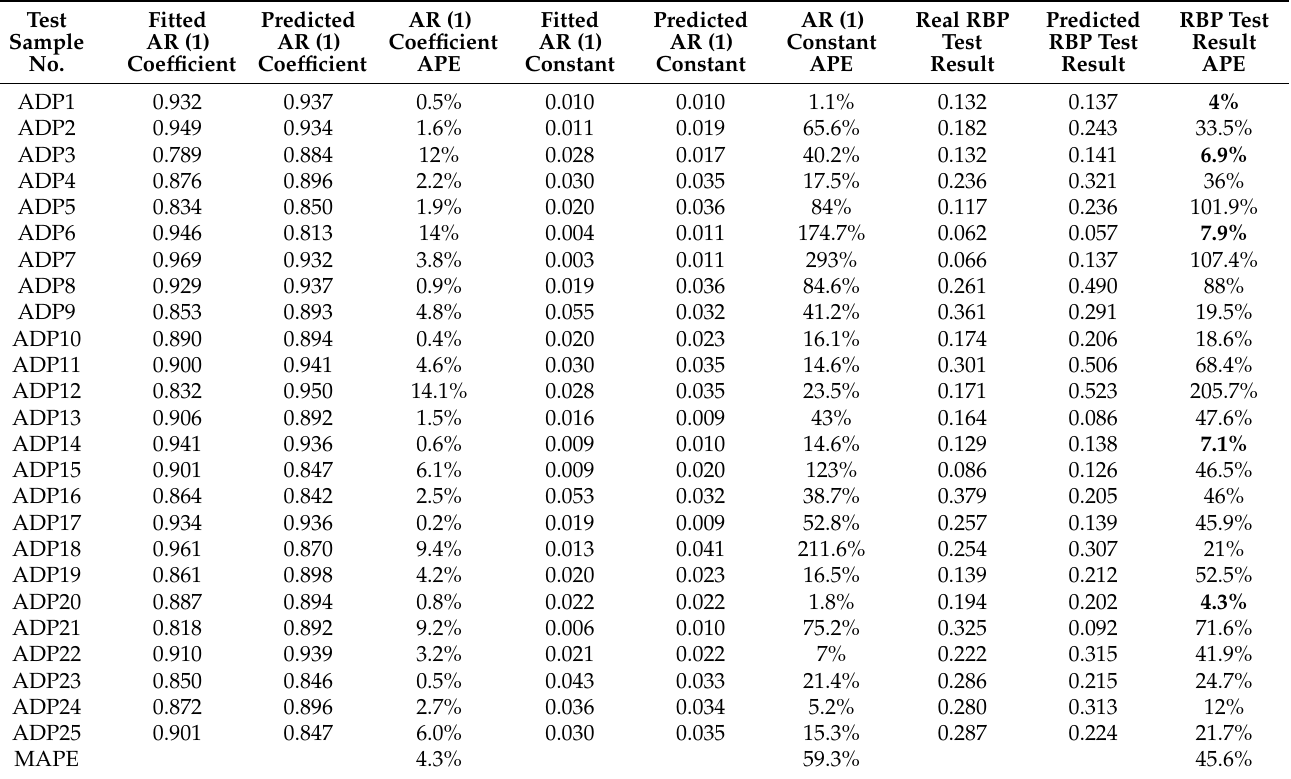
Table 7. The APEs for the AR (1) model coefficient and constant prediction and the biogas yield at 28th day prediction from the LOO cross-validation